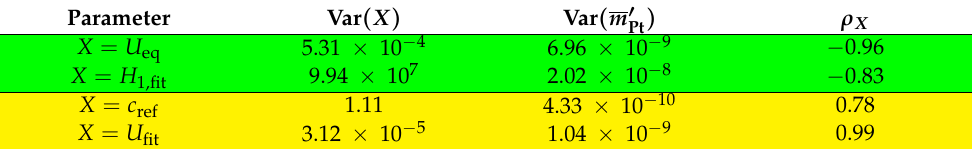
Table 5. Variance and correlation coefficients for input and output